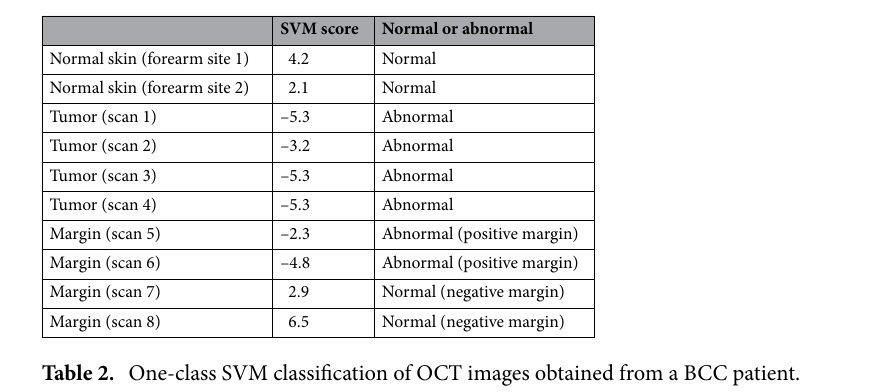
Table 2. One-class SVM classification of OCT images obtained from a BCC